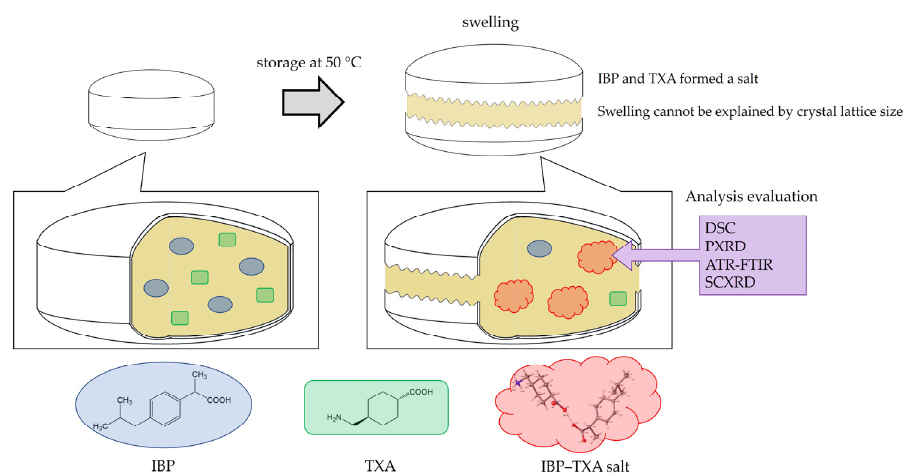
Figure 10. Swelling and salt formation in ibuprofen and tranexamic acid-containing tablets.